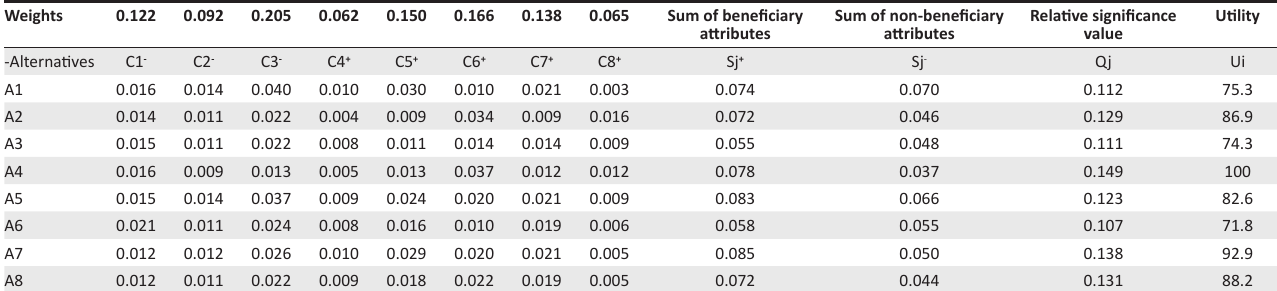
TABLE 4: Normalised weighted decision